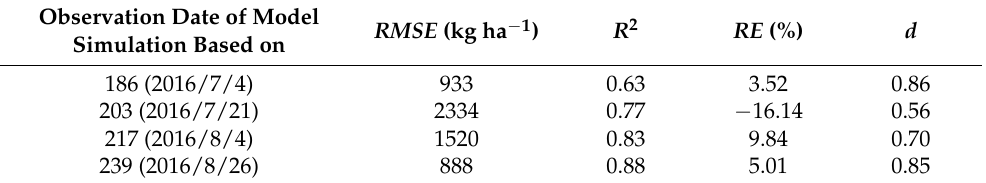
Table 7. Comparisons between the forecasted grain yields in the Jiefangzha sub-irrigation district based on field observation in different days and the measurements 1 . Observation Date of Model Simulation Based